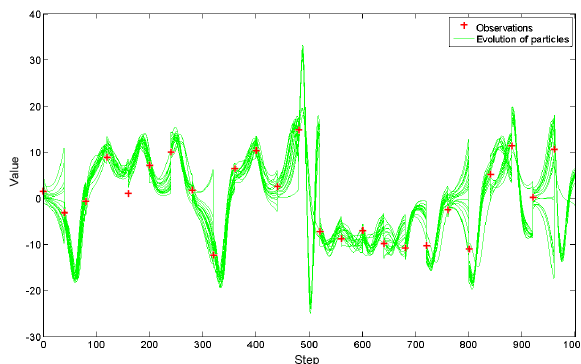
Figure 1. Results of the new PF for the Lorenz-63 model of the x component. The red crosses are observations, the black line is the true state and the blue line represents the new PF results.